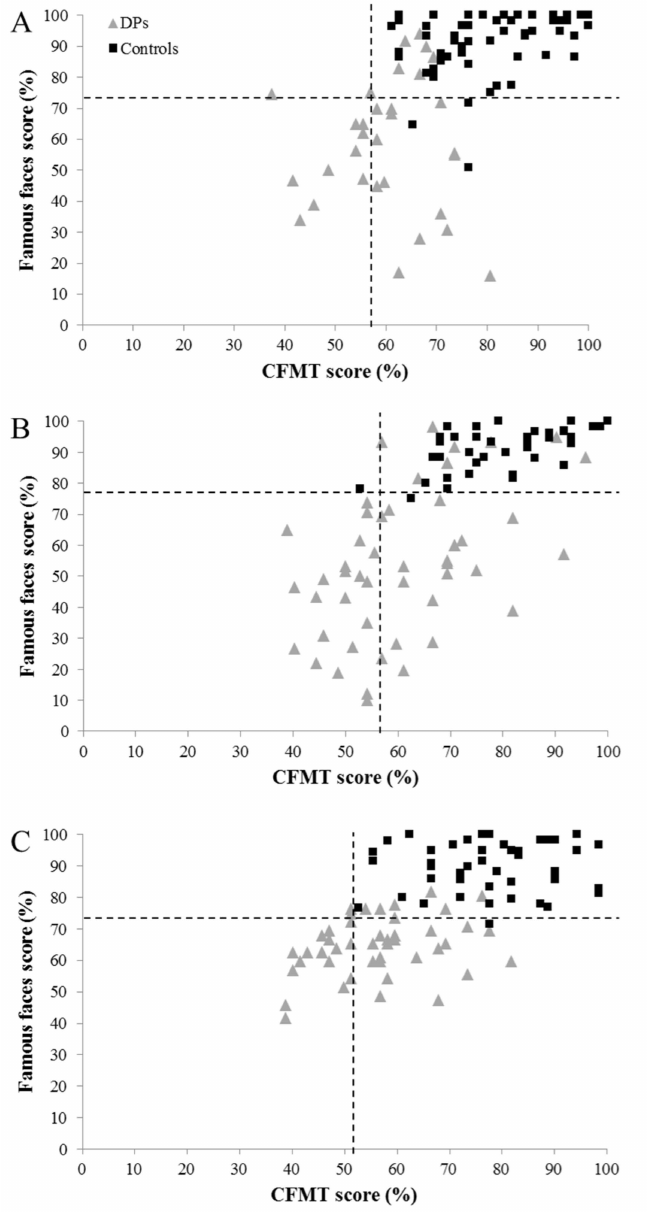
Figure 2. Relationship between CFMT and famous face scores in the self-referred DP and control groups, for ( A ) 18–34 year olds, ( B ) 35–49 year olds, and ( C ) 50–59 year olds (those aged over 60 years are not displayed as more varied performance prohibits interpretation). Dotted lines represent two SDs from the control